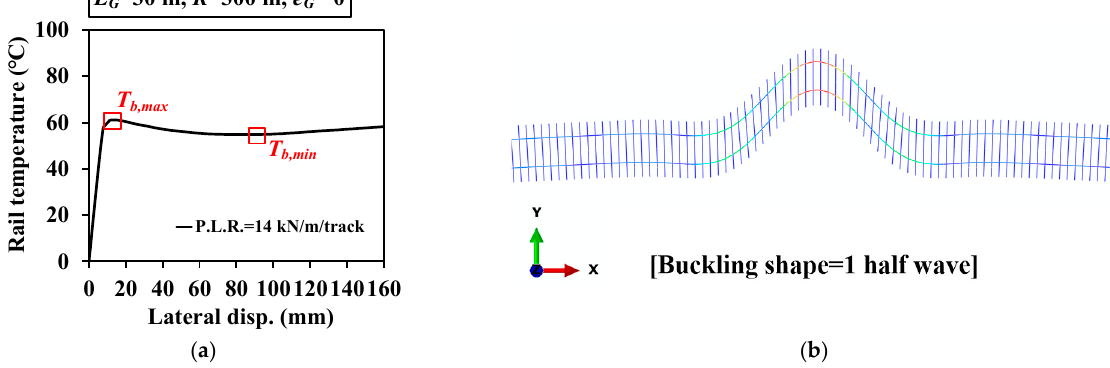
Figure 12. Analysis results ( R = 300 m): ( a ) rail temp. vs. lateral disp.; and ( b ) buckling shape. The difference between T b,max and T b,min of a model with R = 1500 m is larger than that